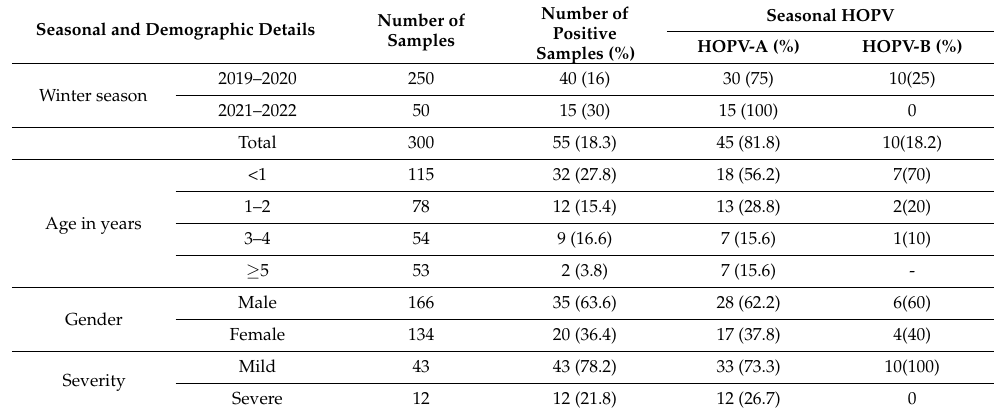
Table 2. The demographic and clinical information and the prevalence of HOPV.